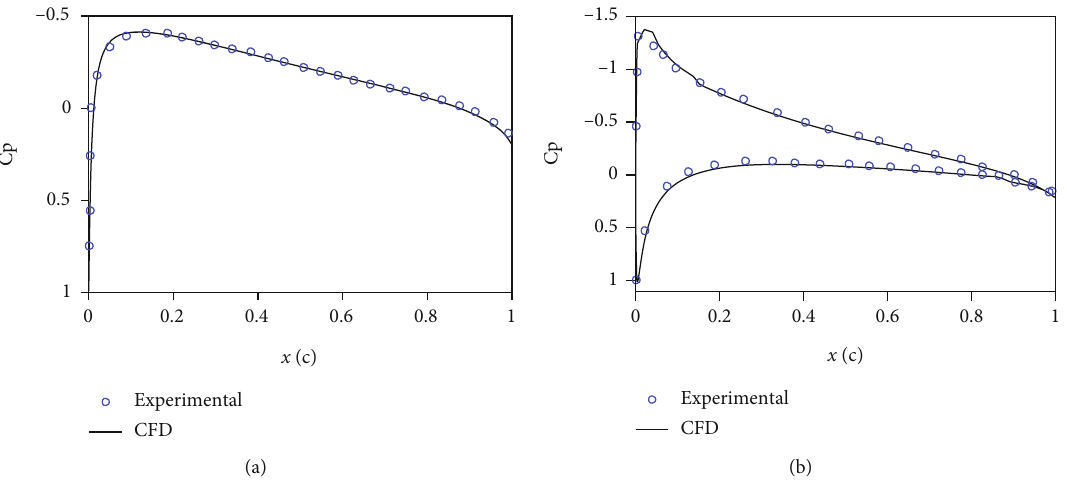
Figure 7: Pressure distribution for NACA0012 at (a) 0 ° AoA and (b) 4 ° AoA.